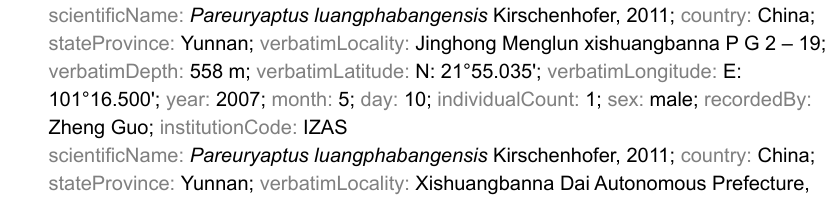
Habitus: Fig. 1b. Male genitalia: Fig. 2a, b. Maxillary palpus: Fig. 3b. Pronotum: Fig. 4b. Body length = 12.6–13.7 mm. Dorsal surface dark brown to black. Terminal maxillary palpimere cylindrical, as long as penultimate one. Pronotum black, rounded,